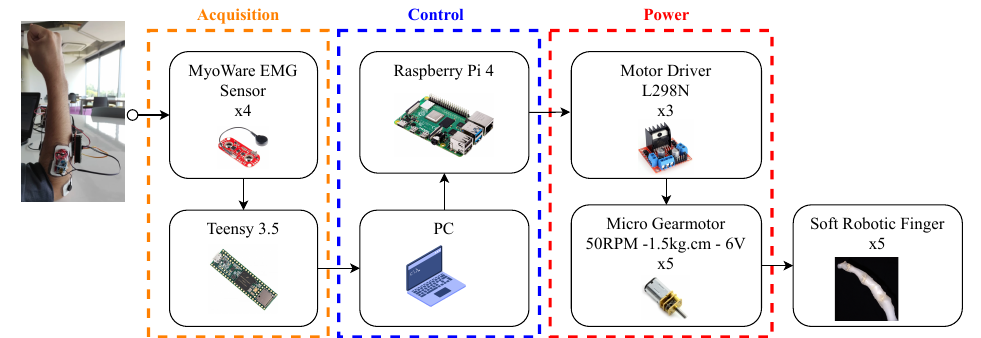
Figure 7. Hardware block diagram of the soft hand prosthesis. Acquisition, control and power layers of the system.